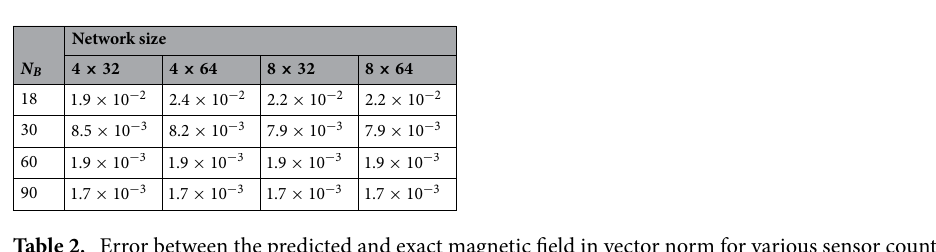
Table 2. Error between the predicted and exact magnetic field in vector norm for various sensor counts and network structures.